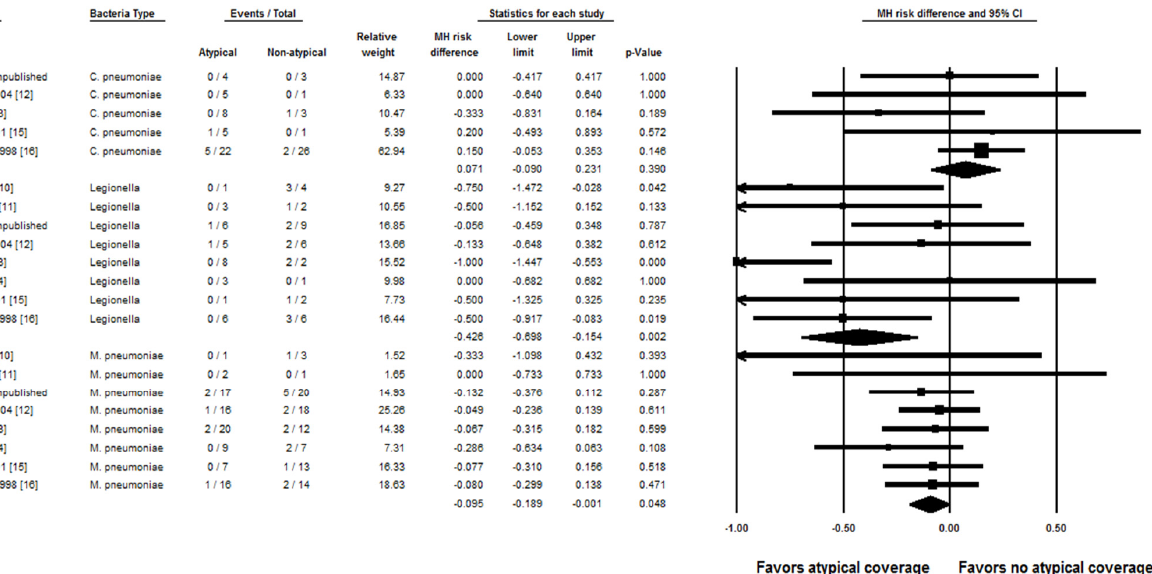
Figure 2. Forest plot showing the risk differences of clinical cure of community-acquired pneumonia associated with each atypical bacteria between adults who empirically received atypical bacterial coverage versus those who did not use random-effects models. Central vertical line, “no difference” point between the two groups; horizontal line, 95% confidence interval; squares, risk differences; diamonds, pooled risk differences. CI, confidence interval; MH, Mantel–Haenszel.